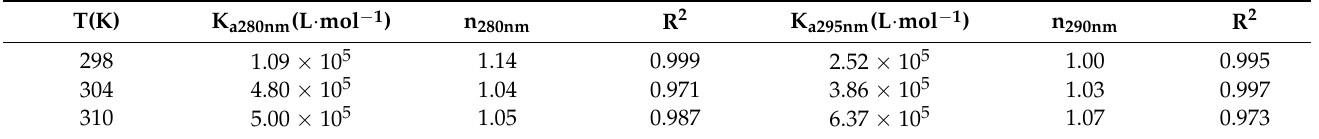
Table 2. The binding constant (K a ) and number of binding sites (n) of EGCG bound to PPI.